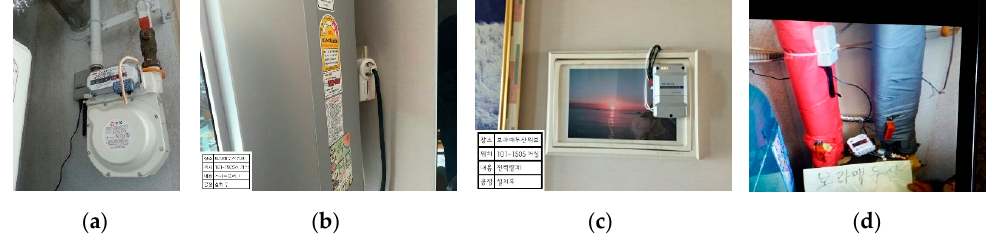
Figure 4. Energy-consumption measurement-system installation: ( a ) gas flowmeter for heating and domestic hot water (DHW), ( b ) watt-hour meter for cooling, ( c ) watt-hour meter for total household power, and ( d ) hot-water calorimeter for DHW.